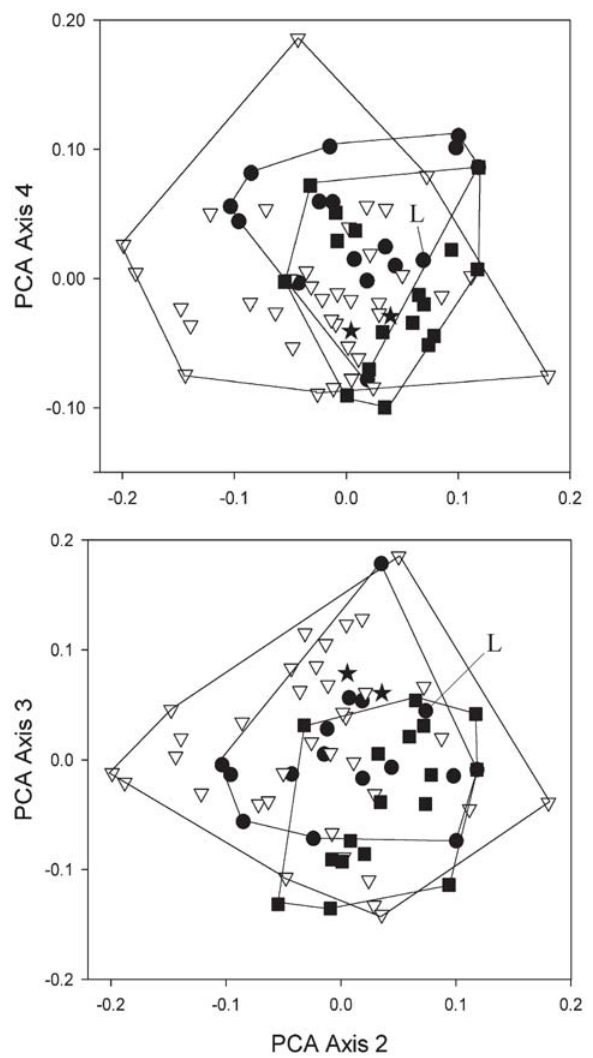
figs. 1-4. Type species: Loricaria steinbachi Regan, 1906, by original designation. Gender: feminine.